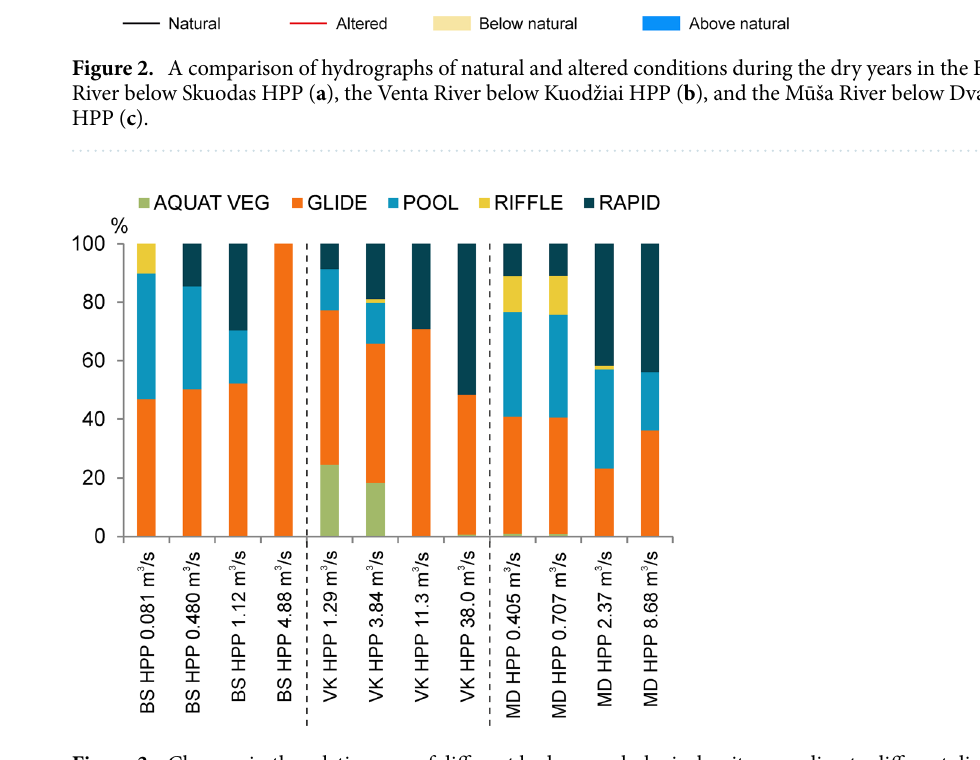
Figure 3. Changes in the relative area of different hydromorphological units according to different discharge conditions (close to Q